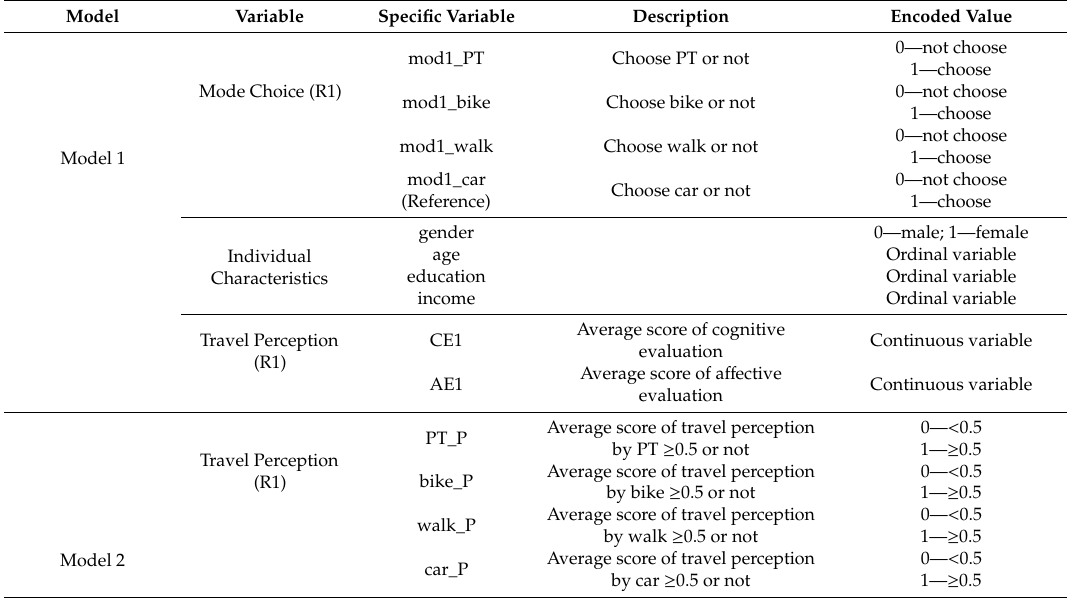
Table 8. Variable descriptions of process model for public transport service